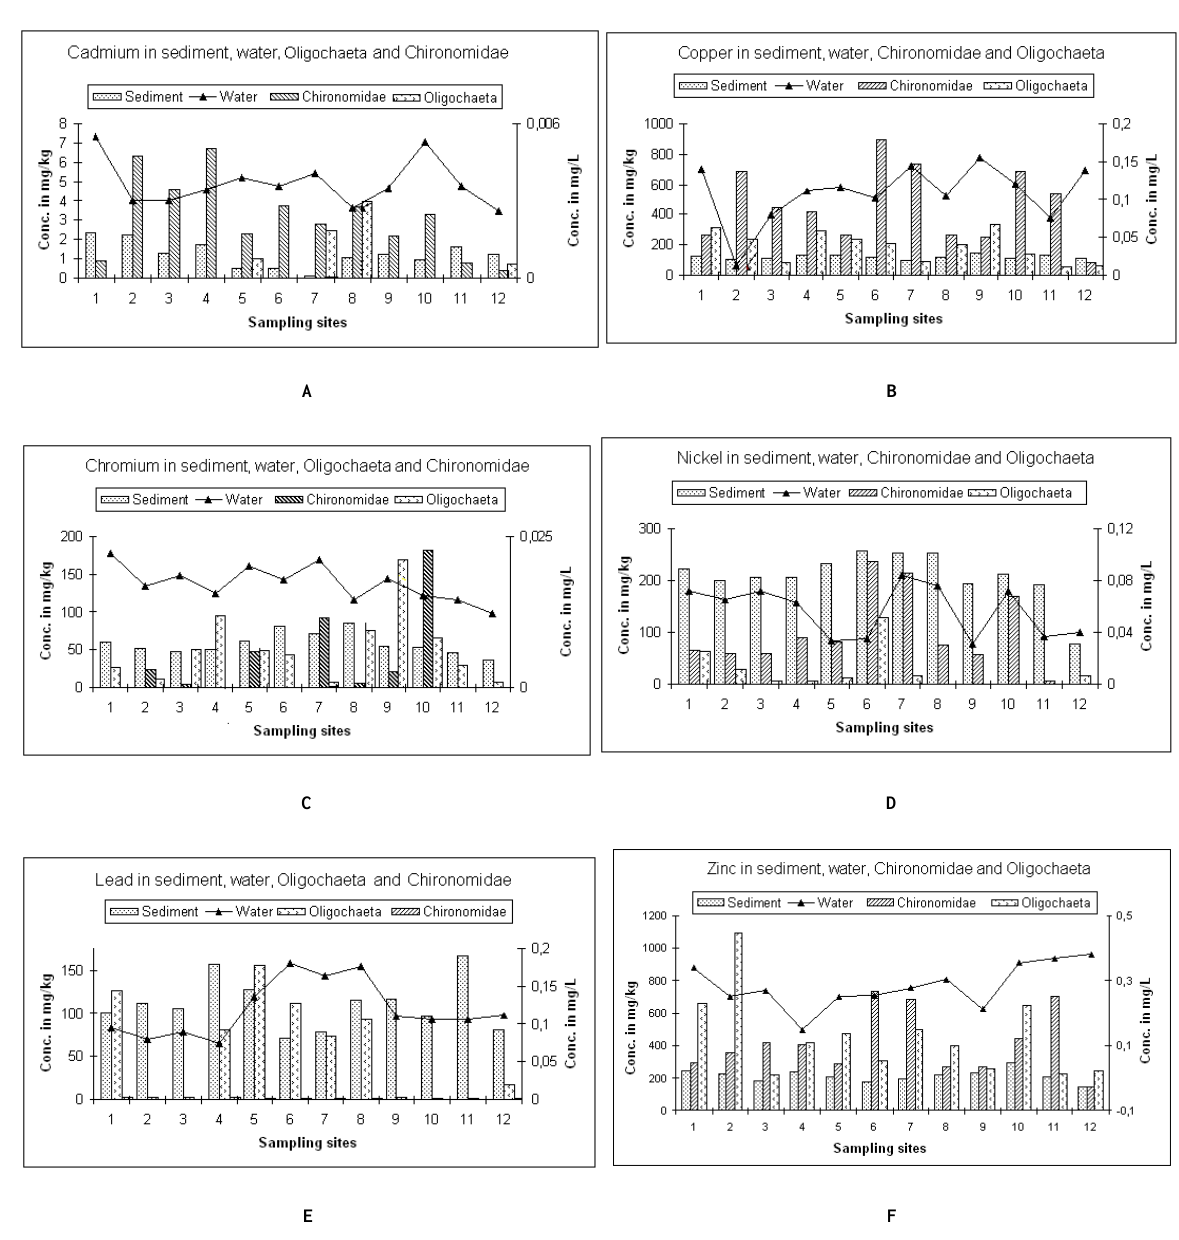
FIGURE 2. Concentrations of metals in the sediments, lake water, oligochaete and chironomid samples (for sediment, oligochaete, and chironomid samples mg kg –1 dry matter).